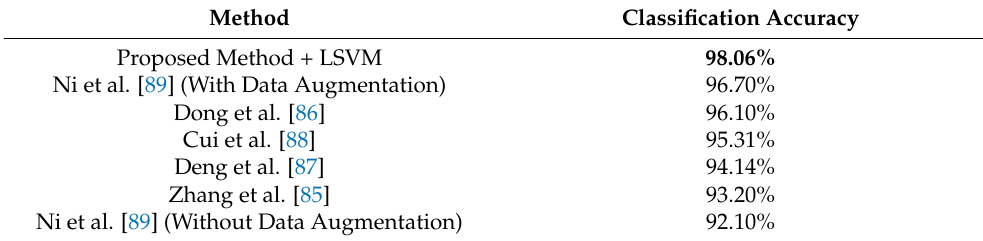
Table 9. The MSTAR three-target dataset comparison results of the proposed method with other methods. The results are sorted in descending order. Bolded value is the result of this